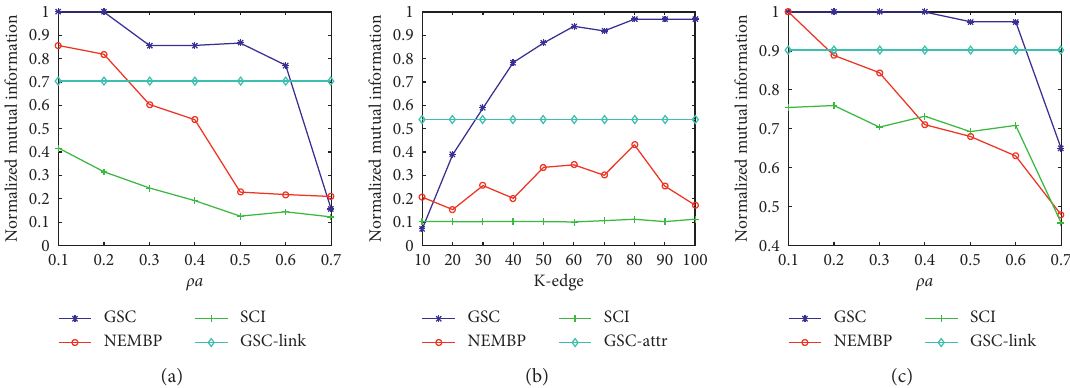
Figure 7: The value of NMI of four methods: (a) on Synthetic 108 with the change of ρ a from 0.1 to 0.7, (b) on Synthetic 108 with the change of keystone links from 10 to 100, and (c) on Synthetic 100 with the change of ρ a from 0.1 to 0.7.